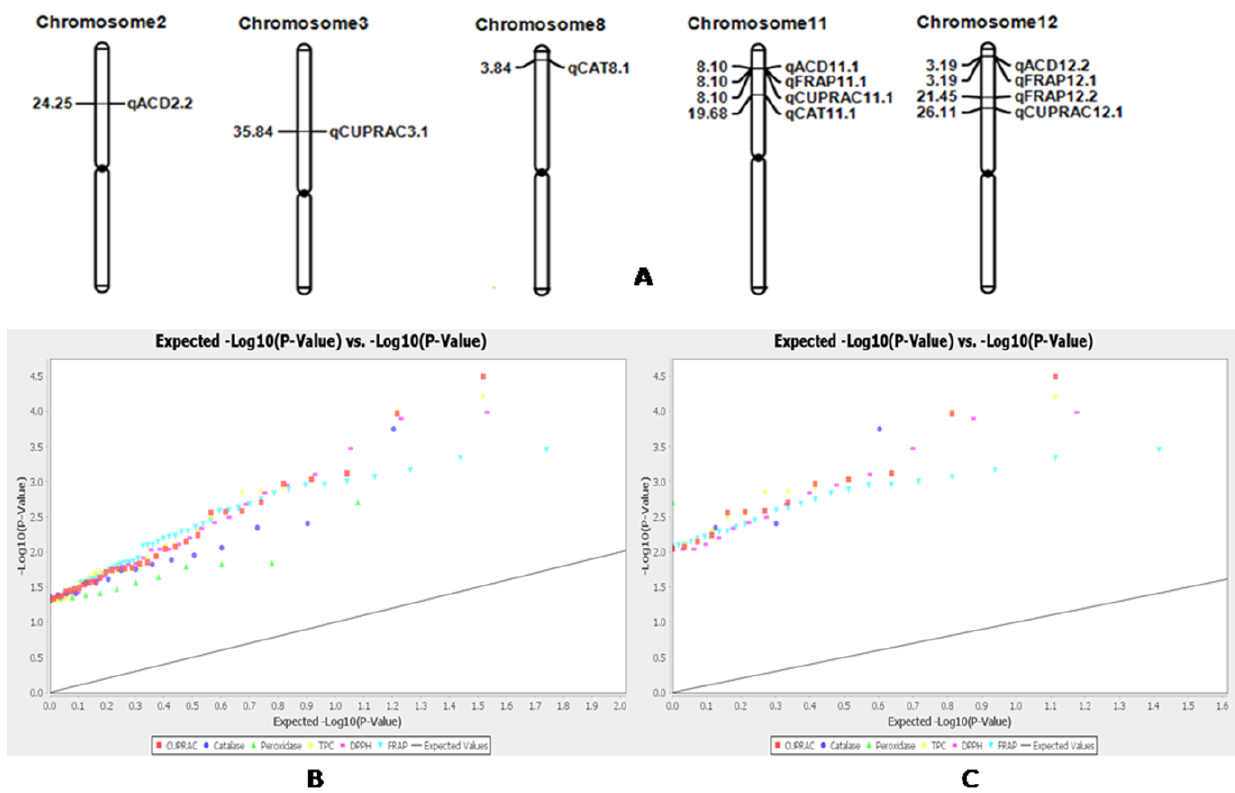
Figure 9. ( A ) Positions (Mb) of the QTLs on the chromosomes regulating the antioxidant traits, cata- lase, peroxidase, DPPH, FRAP and CUPRAC detected by association mapping in rice. B. Distribution of marker–trait association and quantile–quantile (Q–Q) plot generated by generalized linear model analysis for the six antioxidant traits at ( B ) p <0.05 and ( C ) at p